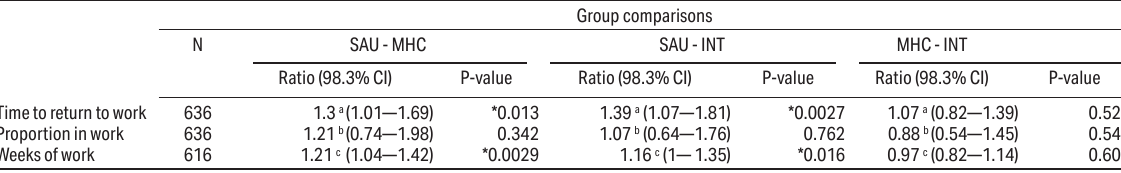
Table 2b. Vocational outcomes at 24-month follow-up: pairwise comparisons . [MHC=mental healthcare; SAU=service as usual; INT=IBBIS inte- grated intervention; IQR=interquartile range; CI=confidence interval.]